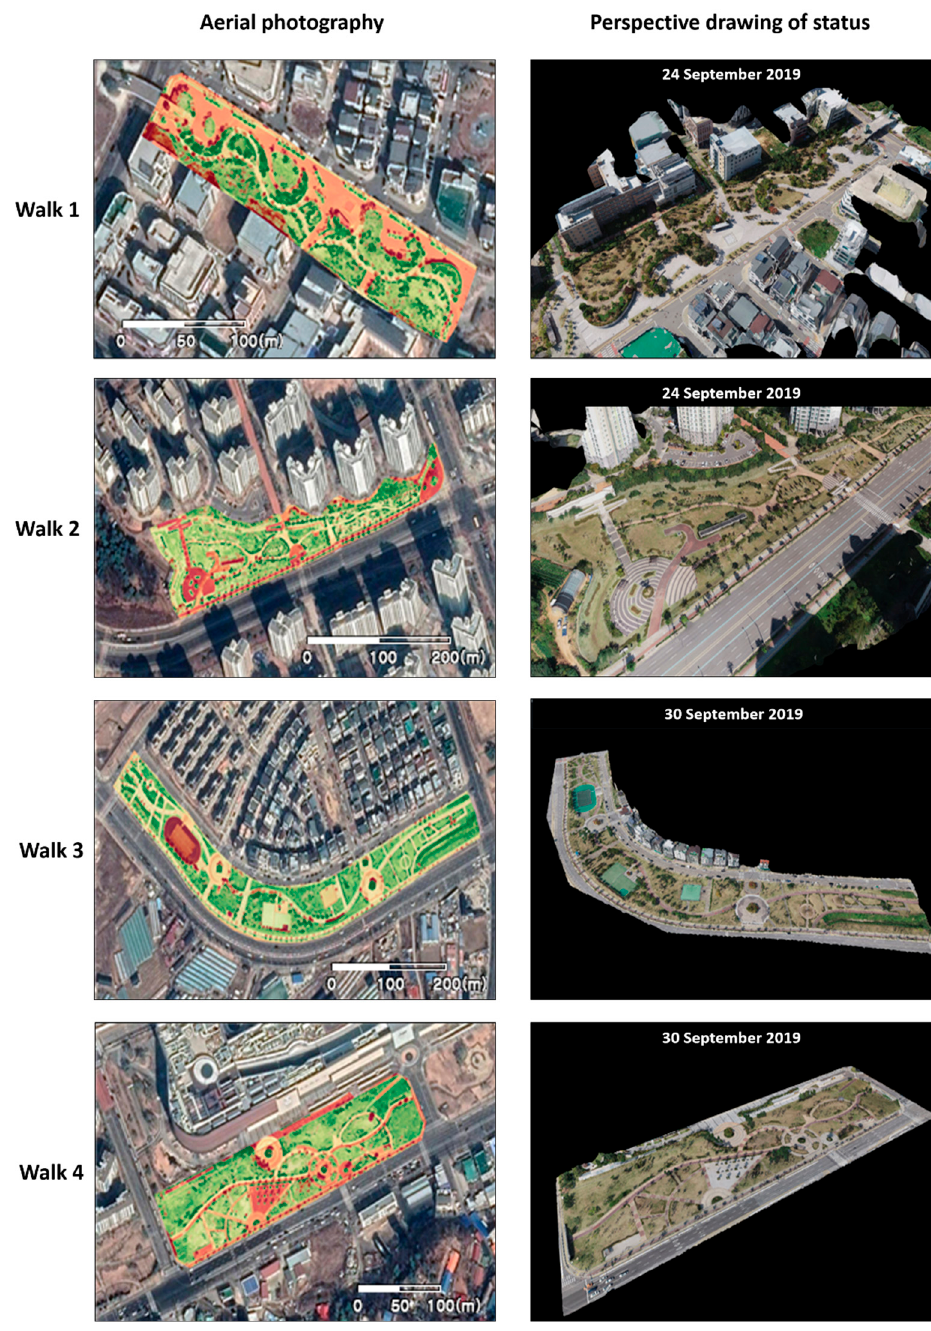
Figure 4. Photos of the land cover status of the walking spheres-4 study sites.